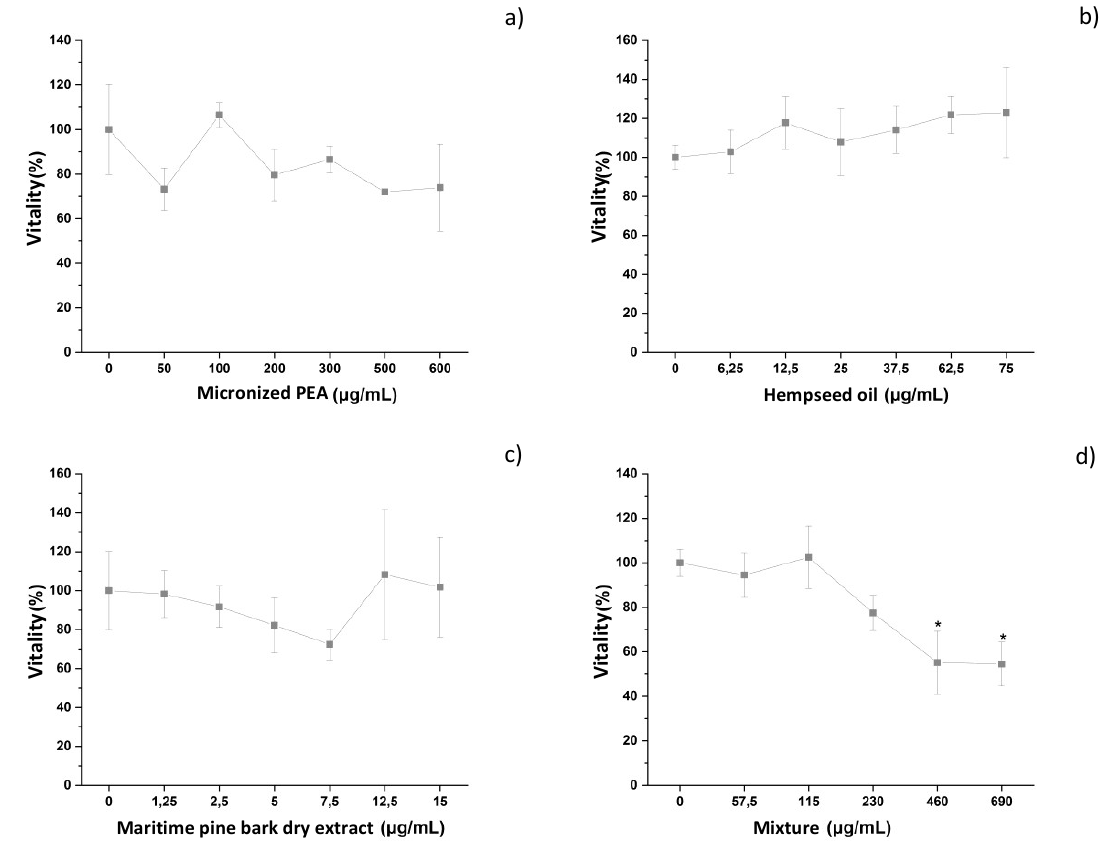
Figure 2. Vitality of differentiated THP-1 cells after treatment with different concentrations of ( a ) micronized PEA, ( b ) hempseed oil, ( c ) maritime pine bark dry extract, and ( d ) mixture. * vitality < 70%.